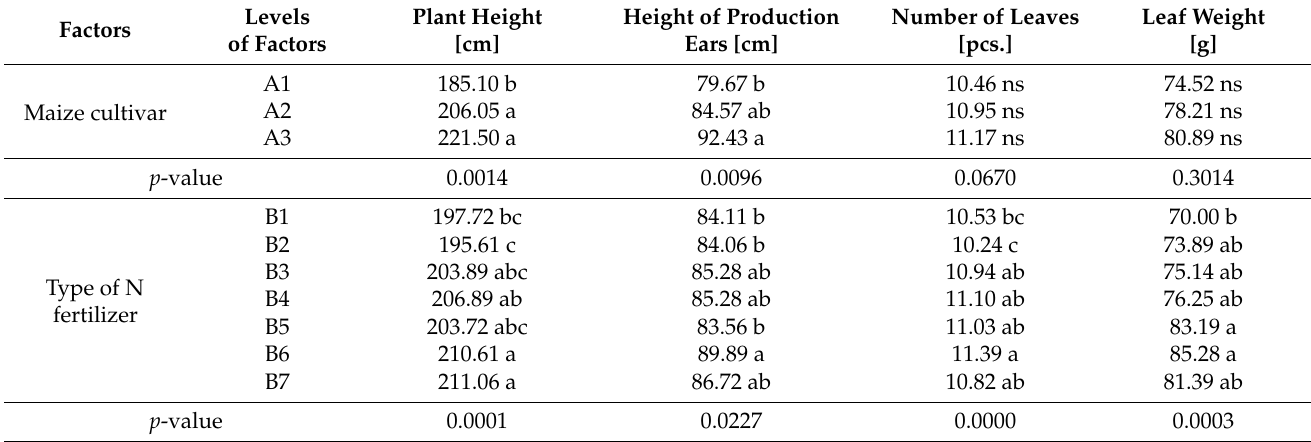
Table 4. Average values of morphological features of maize plants for cultivars (A) and fertilizer (B).